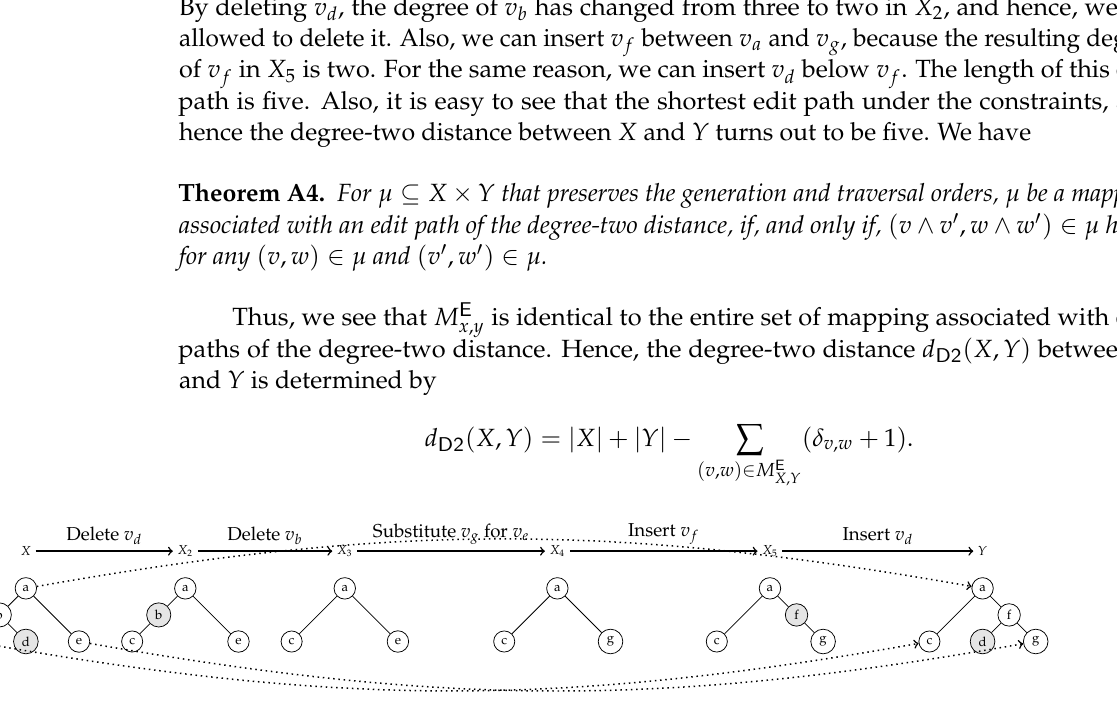
Figure A4. An edit path of the degree-two